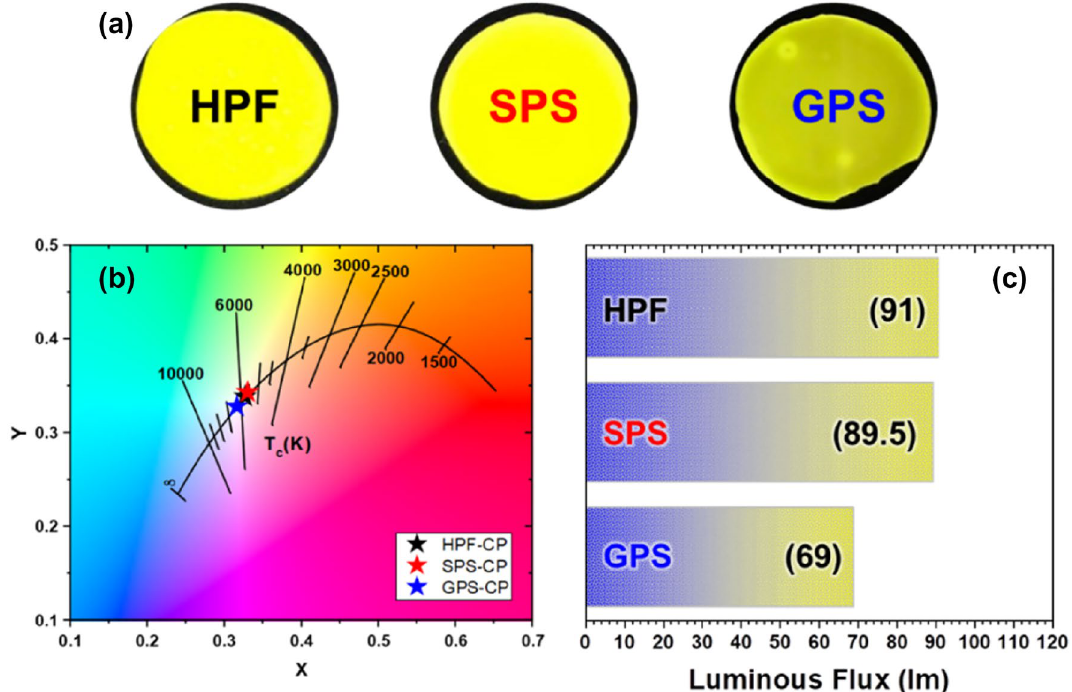
Figure 2. ( a ) Photographs of the CPs prepared by different method (from left to right: HPF, SPS, and GPS). ( b , c ) CIE color coordinates and luminous flux of CPs,